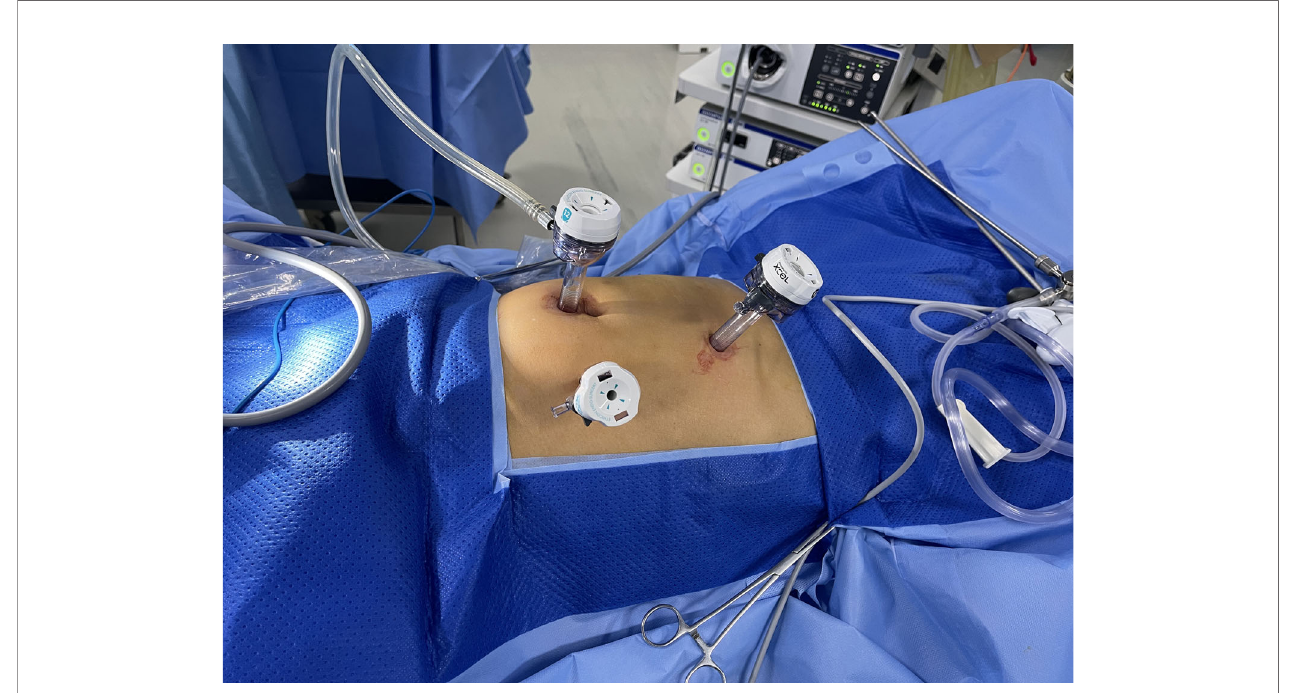
FIGURE 1 | Trocar placement.